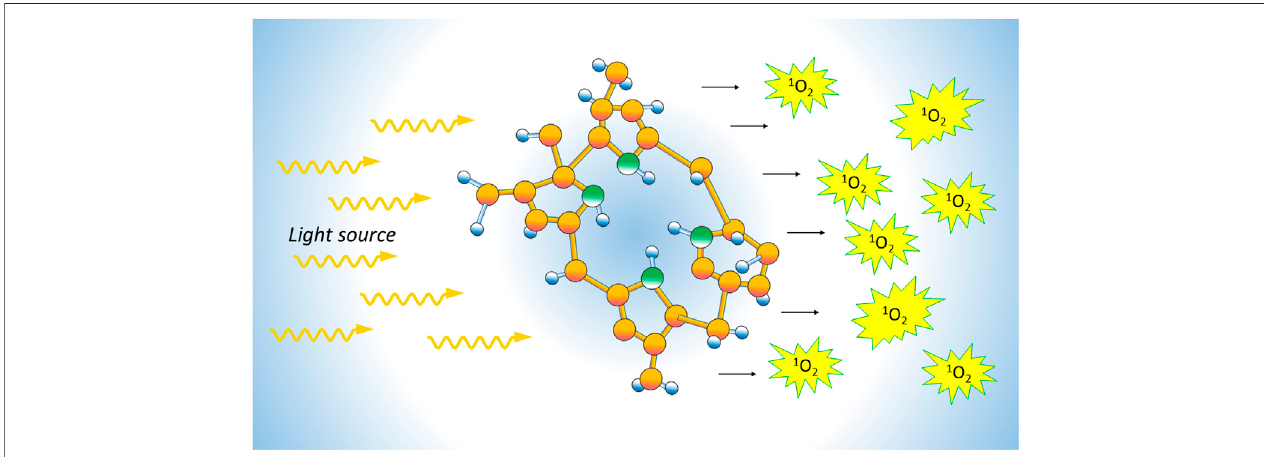
FIGURE 1 | The fi gure describes the basic steps of PDT that is based on the induced photo conversion of a PS that trigger the production of cytotoxic reactive oxygen species leading to the killing of tumor cells.